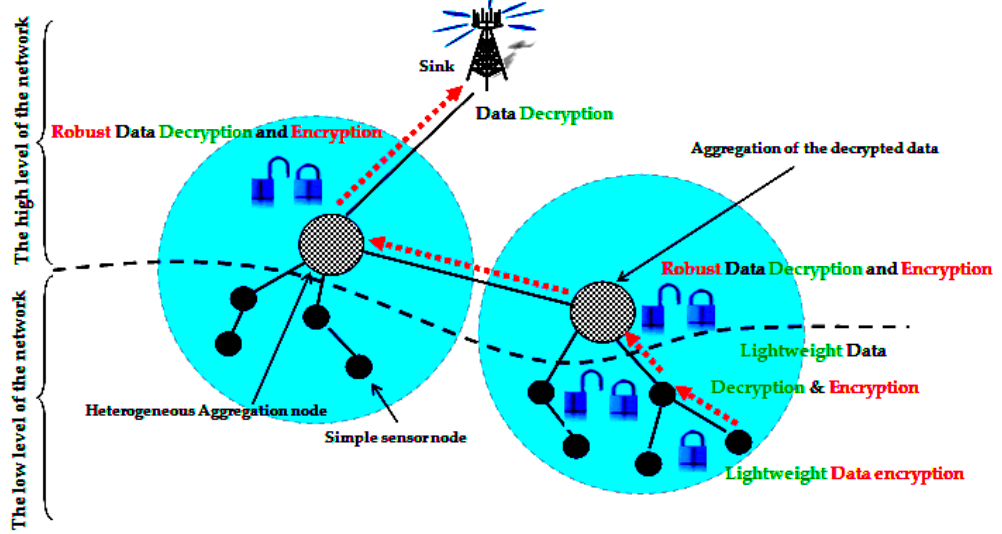
Figure 5. Two levels data aggregation security approach.